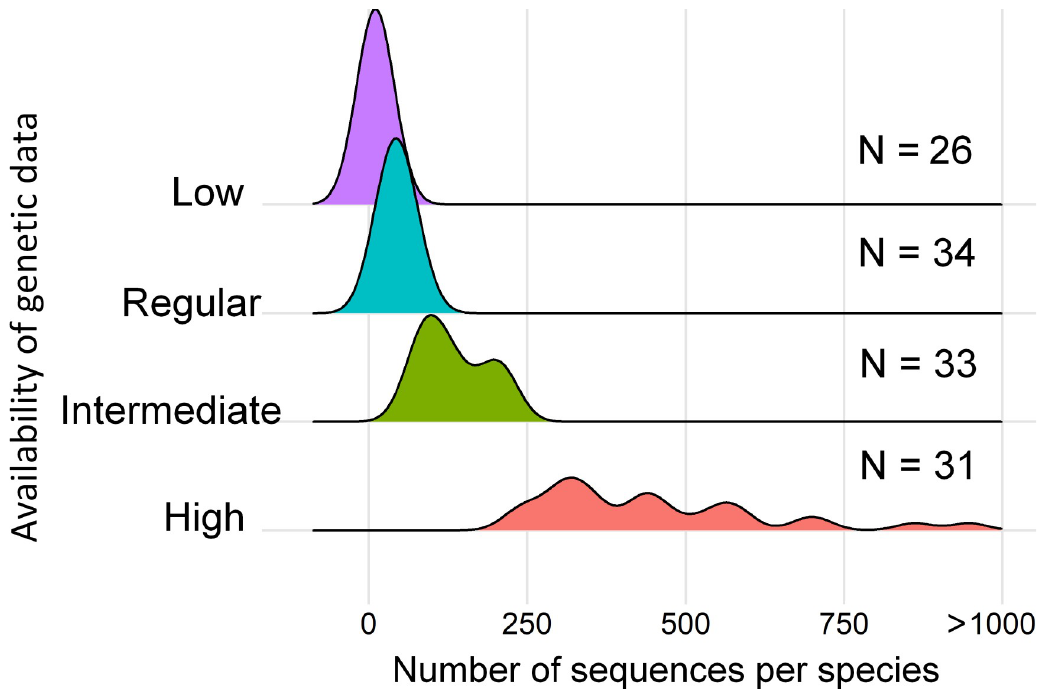
Fig 4. Availability of genetic data for mammalian species that occur in both Amazonia and the Atlantic Forest. Species with “Low” availability of genetic data have one to 22 sequences; Species with “Regular” availability of genetic data have 23 to 74 sequences; Species with “Intermediate” availability of genetic data have 75 to 225 sequences; and Species with “High” availability of genetic data have 226 to over 1000